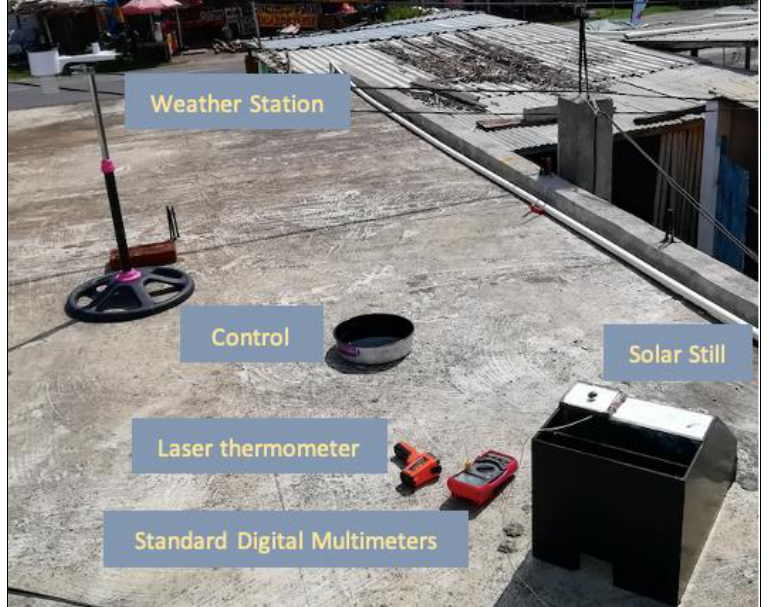
Figure 3. Equipment used for in-field monitoring. The instruments used in the monitoring are shown, including the control basin, the weather station, laser thermometer, multimeters, and the thermocouples installed in the solar still.